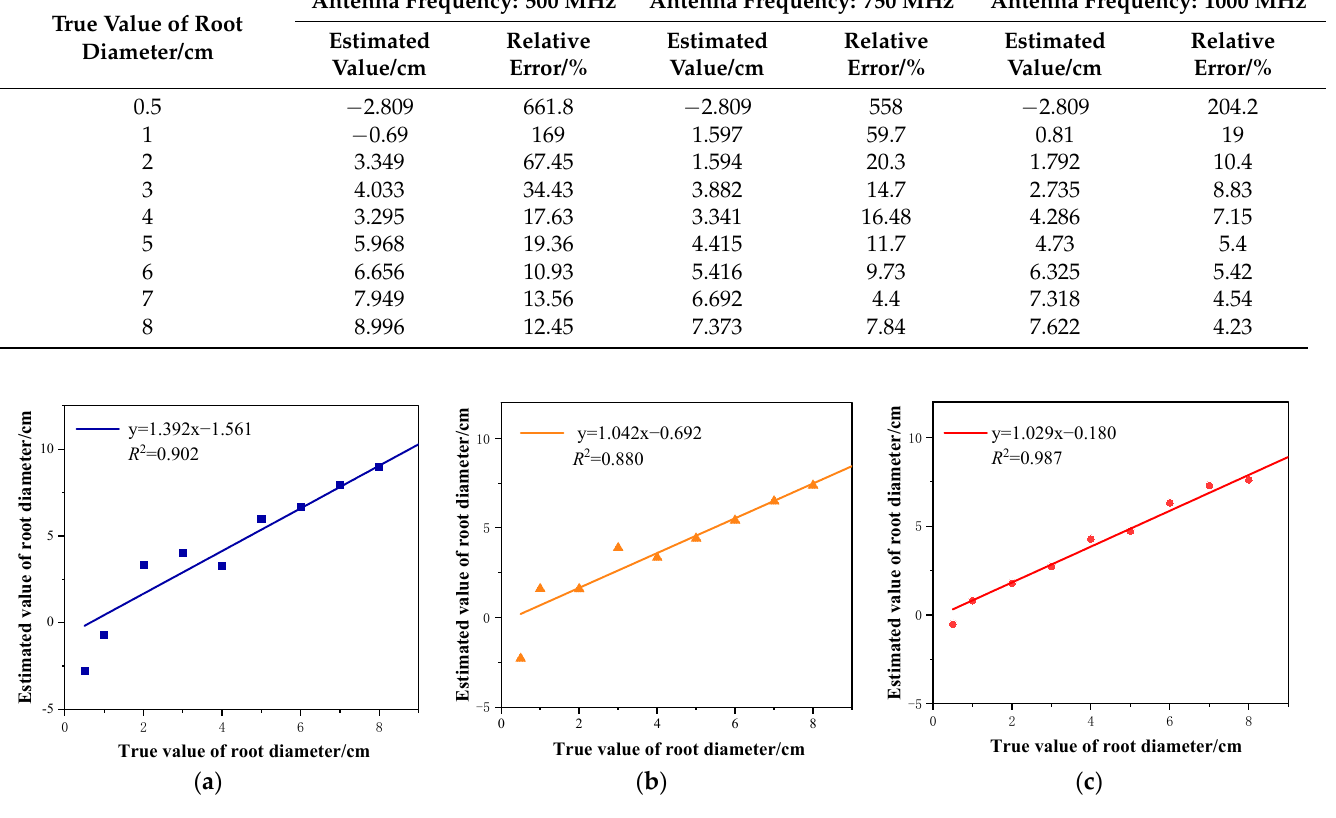
Figure 14. Linear fitting of root diameter estimation results: ( a ) estimated root radius at an antenna frequency of 500 MHz; ( b ) estimated root radius at an antenna frequency of 750 MHz; ( c ) estimated root radius at an antenna frequency of 1000 MHz. Table 2. Root diameter estimation results.